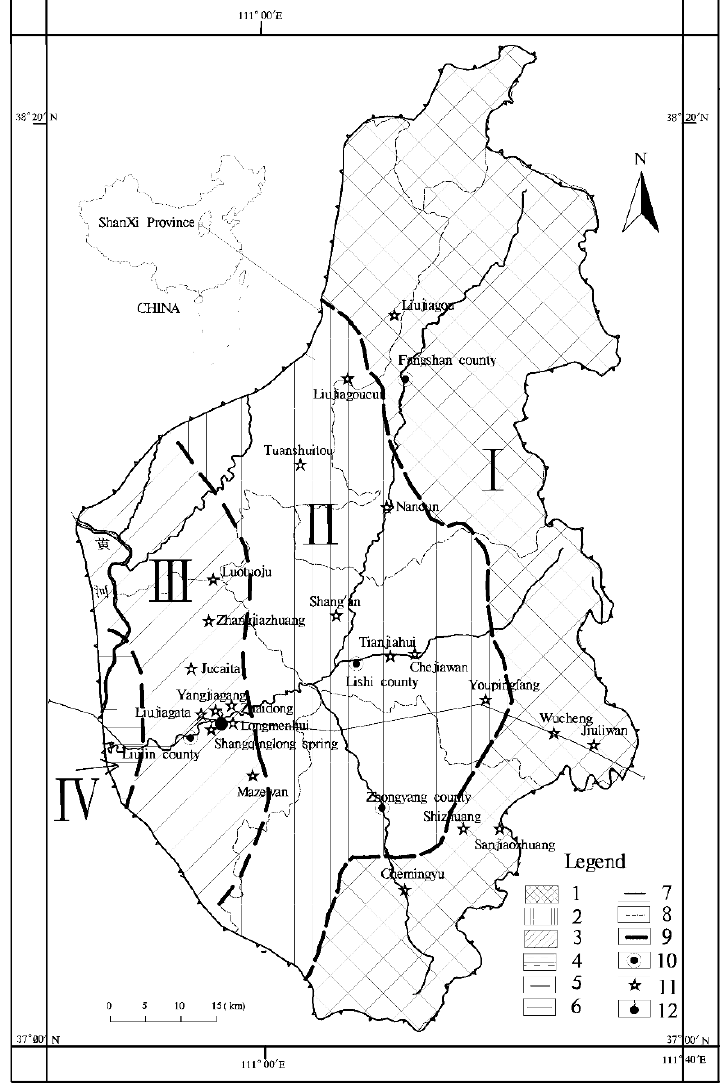
Figure 1. The partition map of hydrogeology-hydrogeochemical of Liulin spring area. 1. zone I; 2. zone II; 3 . zone III; 4. zone IV; 5. river; 6. section line; 7. the boundary of Lulin spring area; 8. county boundary; 9. the segmentation borderline; 10. county; 11. water-sample point; 12. Liulin spring.